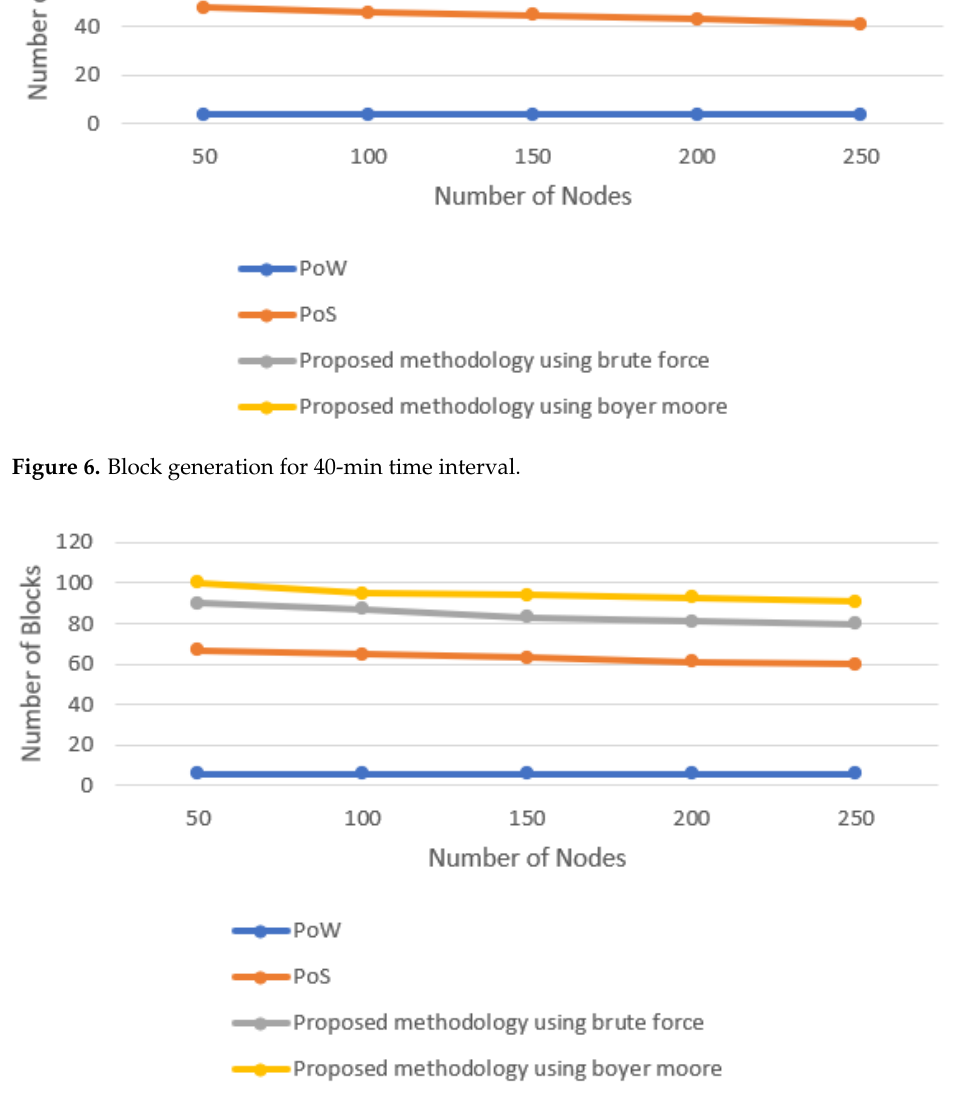
Figure 7. Block generation for 60-min time